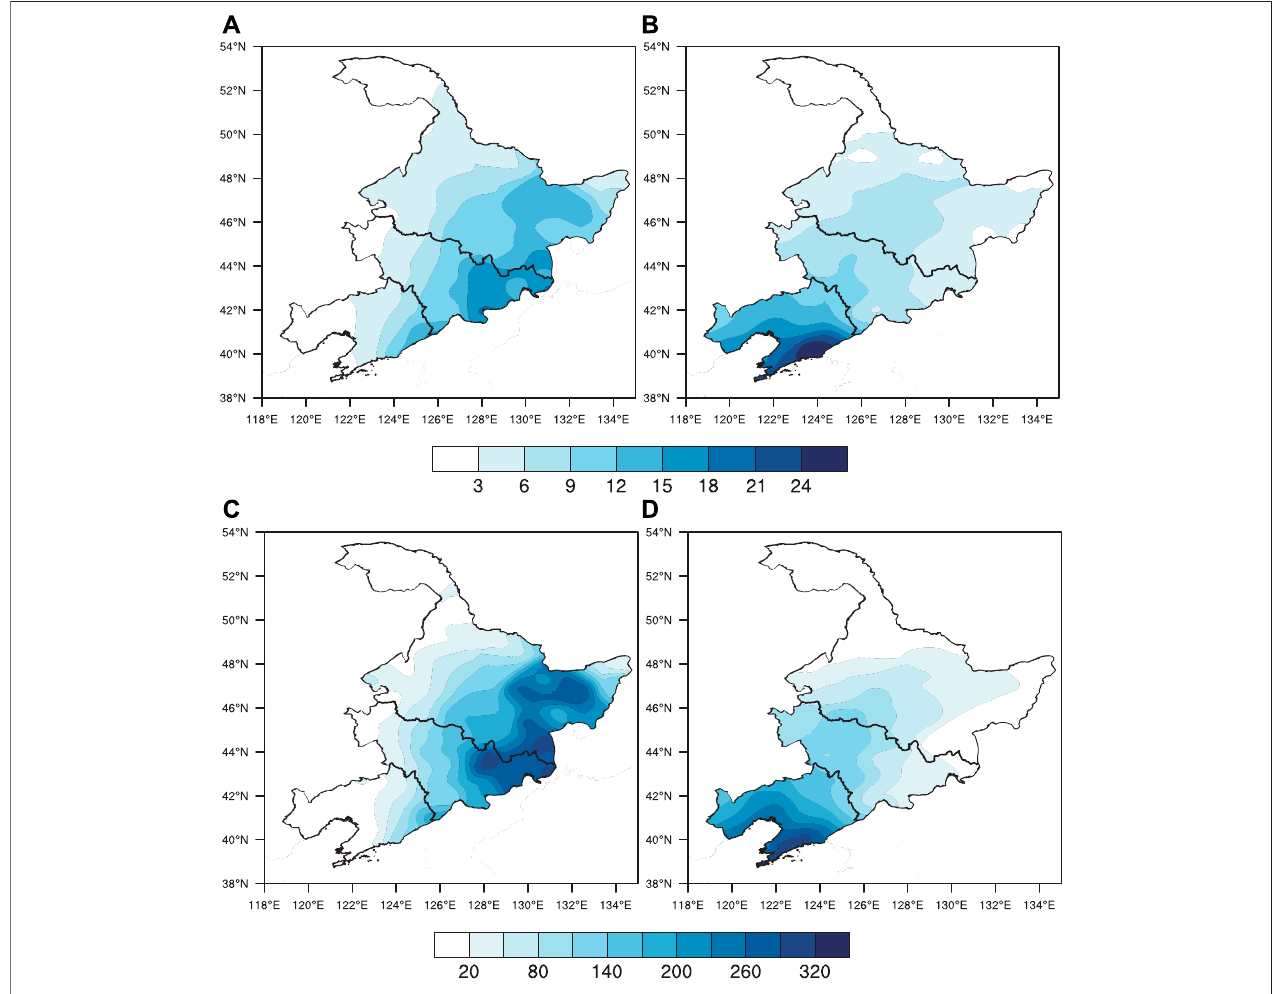
FIGURE 7 | (A,B) Average precipitation in NEC (mm/day) and (C,D) precipitation anomaly percentages (%) for the different types of northward-moving TCs. (A,C) are for the eastern-track type TCs; (B,D) are for the turning type TCs.